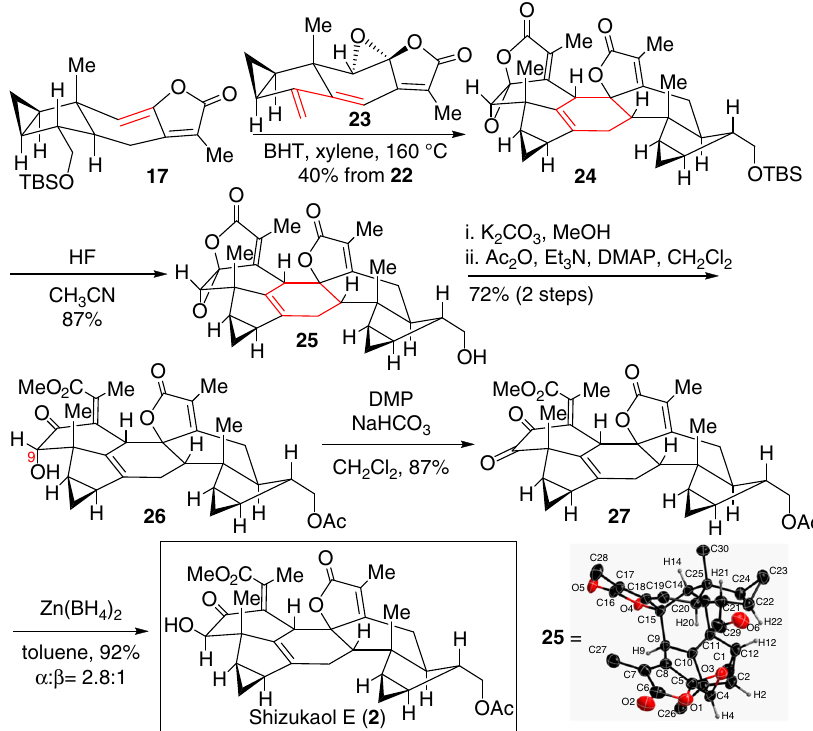
Fig. 6 Total synthesis of shizukaol E ( 2 ). BHT butylated hydroxytoluene, DMP Dess – Martin periodinane, DMAP 4-dimethylaminopyridine